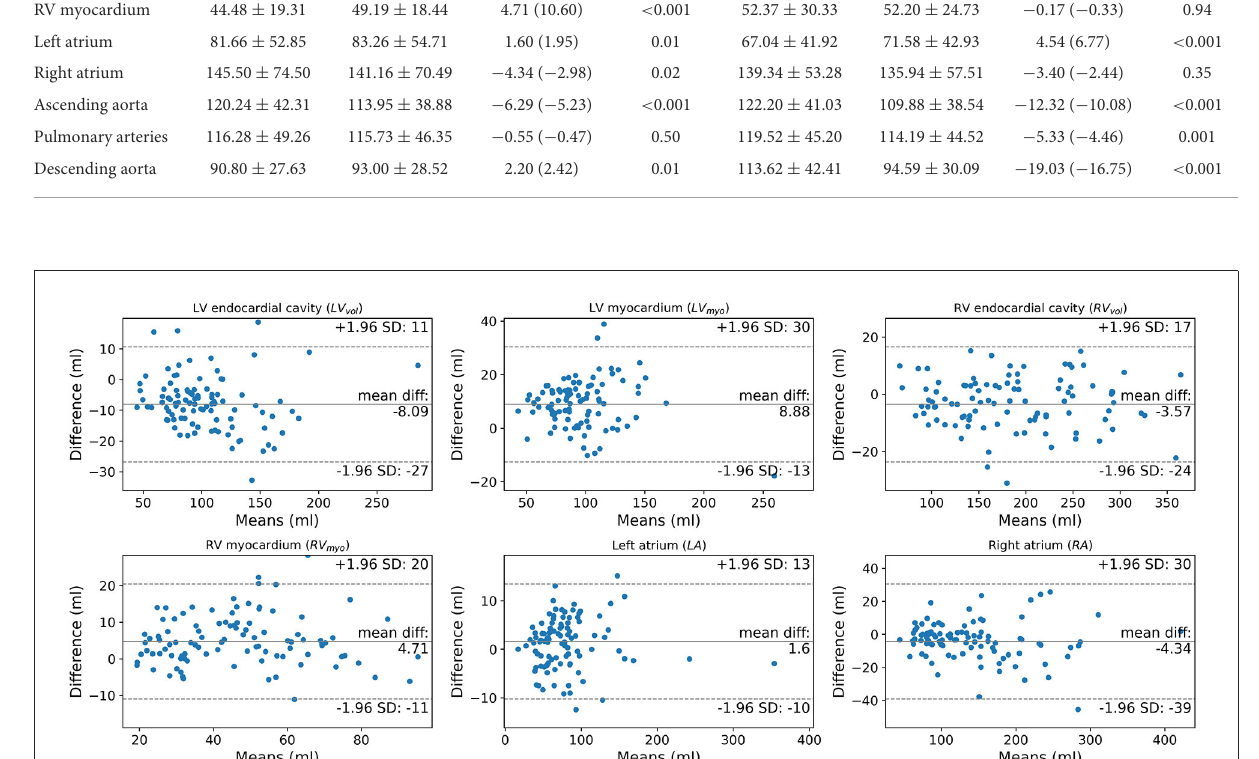
challenge was won with a whole heart segmentation DSC of 0.91, which compares very favourably with the value of 0.90 for this study if the RV myocardium is excluded. The DSC values presented in this study exceed the highest score in the challenge table for all right sided cardiac structures; RV endocardial cavity 0.92 vs. 0.91, RA 0.90 vs. 0.89 and PA 0.93 vs.